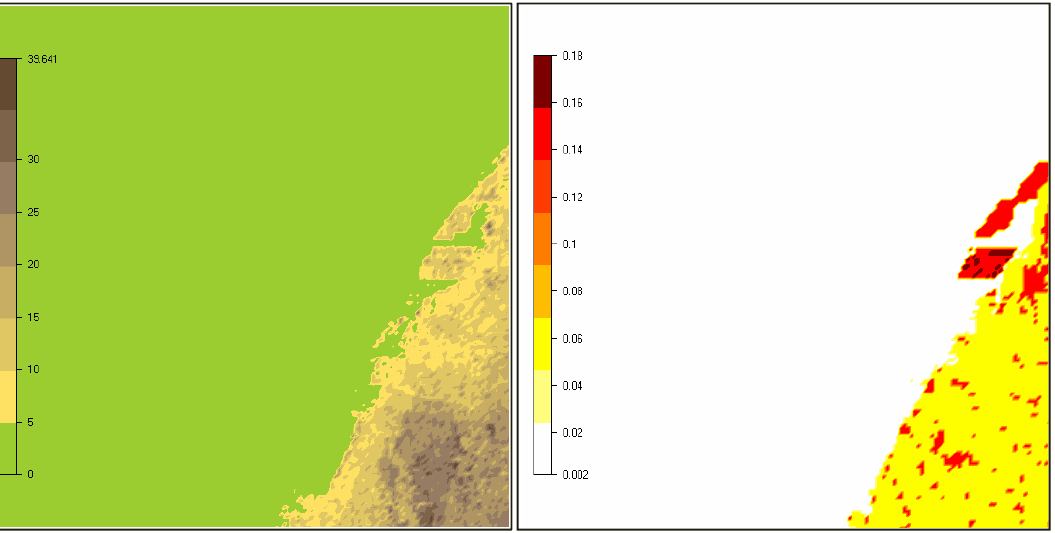
Figure 4. Elevation ( left ) and roughness ( right ) of terrain of Changhua nearshore Fig ure 4. Elevation (left) and roughness (right) of terrain of Changhua nearshore area. To ensure that the AEP calculation converged, the mesh of the terrain was calculated from 184,960 to 961,000 cells (Table 1), with the height layers set at 40 cells.